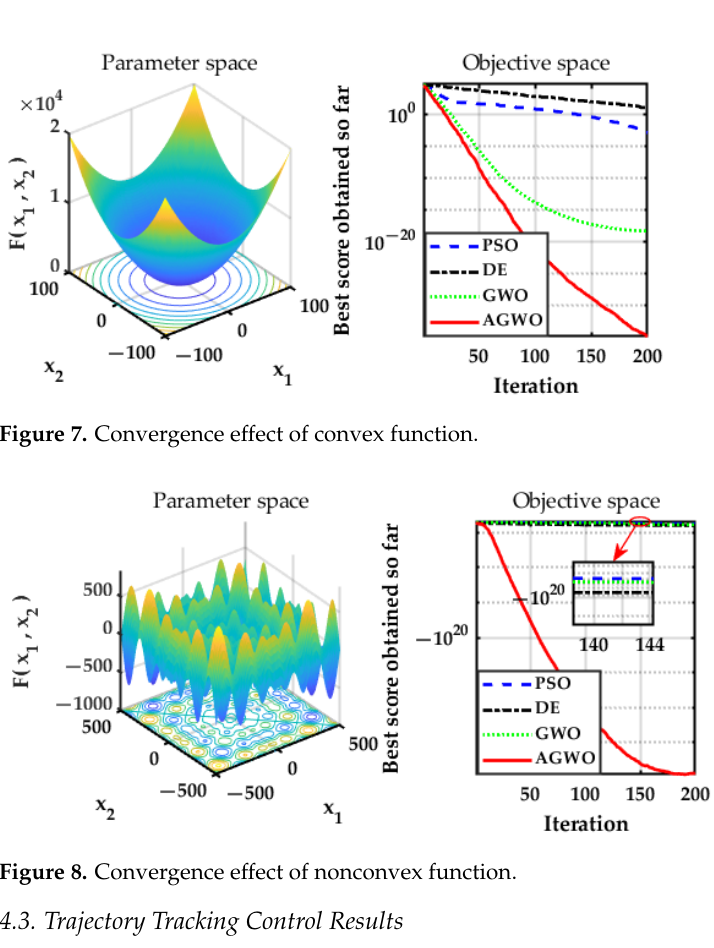
13 of 20 ( c ) Figure 6. Comparison chart of actual value and predicted value of test set: ( a ) The actual and pre- dicted values of surge velocity; ( b ) The actual and predicted values of sway velocity; ( c ) The actual and predicted values of yaw angular velocity. 4.2. Optimization Results of AGWO Two typical functions (convex function and nonconvex function) are chosen to test the optimization performance of AGWO, and the results are shown in Figures 7 and 8. First of all, the two figures show that the optimization effect of AGWO is better than the other three methods. It can be seen from Figure 7 that AGWO has a great improvement in the convergence speed compared with GWO, especially in the later stage. It indicates that the existence of adaptive weights can accelerate the convergence of AGWO. In Figure 8,